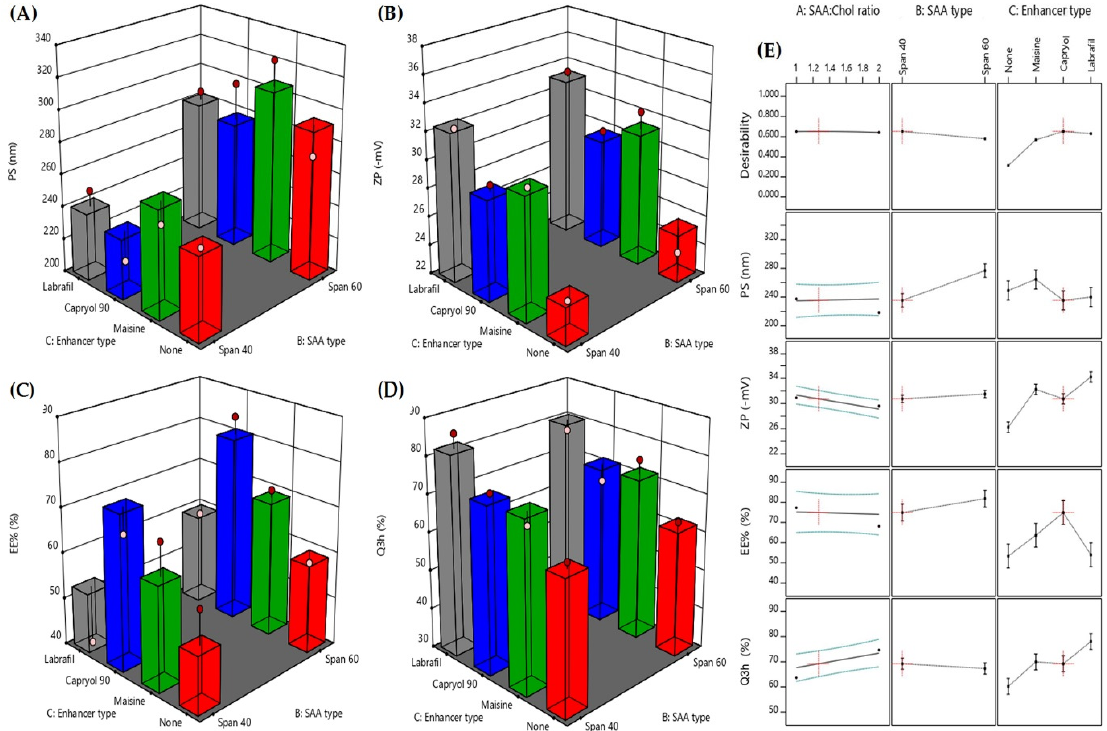
Figure 1. Response 3D plots for the e ff ect of the studied formulation factors on the obtained responses ( A )–( D ) and the desirability ( E ). * (SAA) is